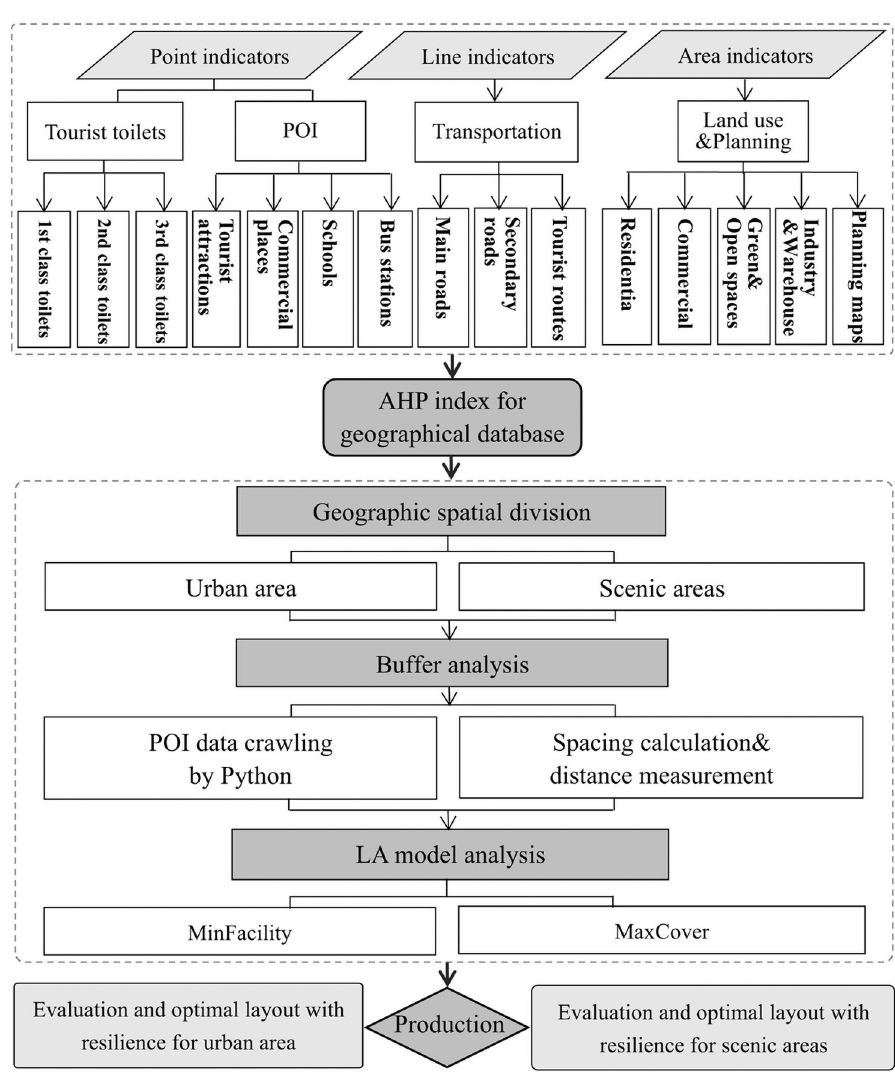
Fig 4. Flowchart (copyright hold by the